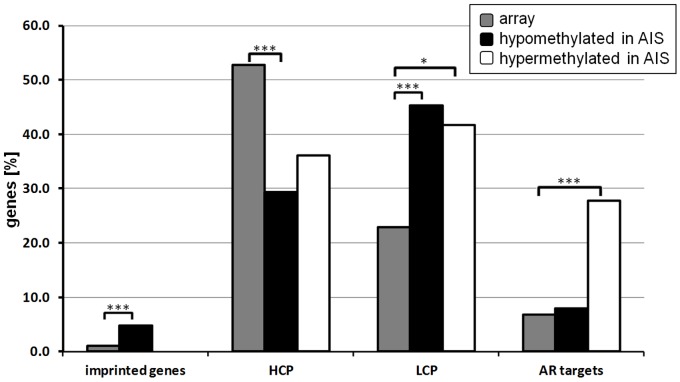
Enrichment of genes either hypo- or hypermethylated in AIS as compared to normal controls.The bar plots show percentage of loci either located in imprinted genes, genes containing either promoters with high CpG (HCP) or low CpG (LCP) content as well as the percentage of AR target genes as determined by the GATHER tool. Grey bars: percentage of genes present on the array, black bars: percentage of genes hypomethylated and white bars: percentage of genes hypermethylated in AIS patients. p-values have been determined applying χ2-test.